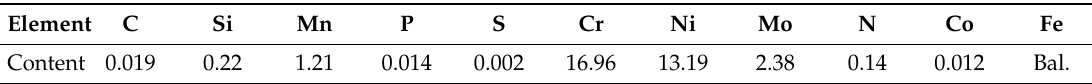
Table 1. Chemical composition of 316LN SS used in the present work (mass fraction, %). Element C Mn Content